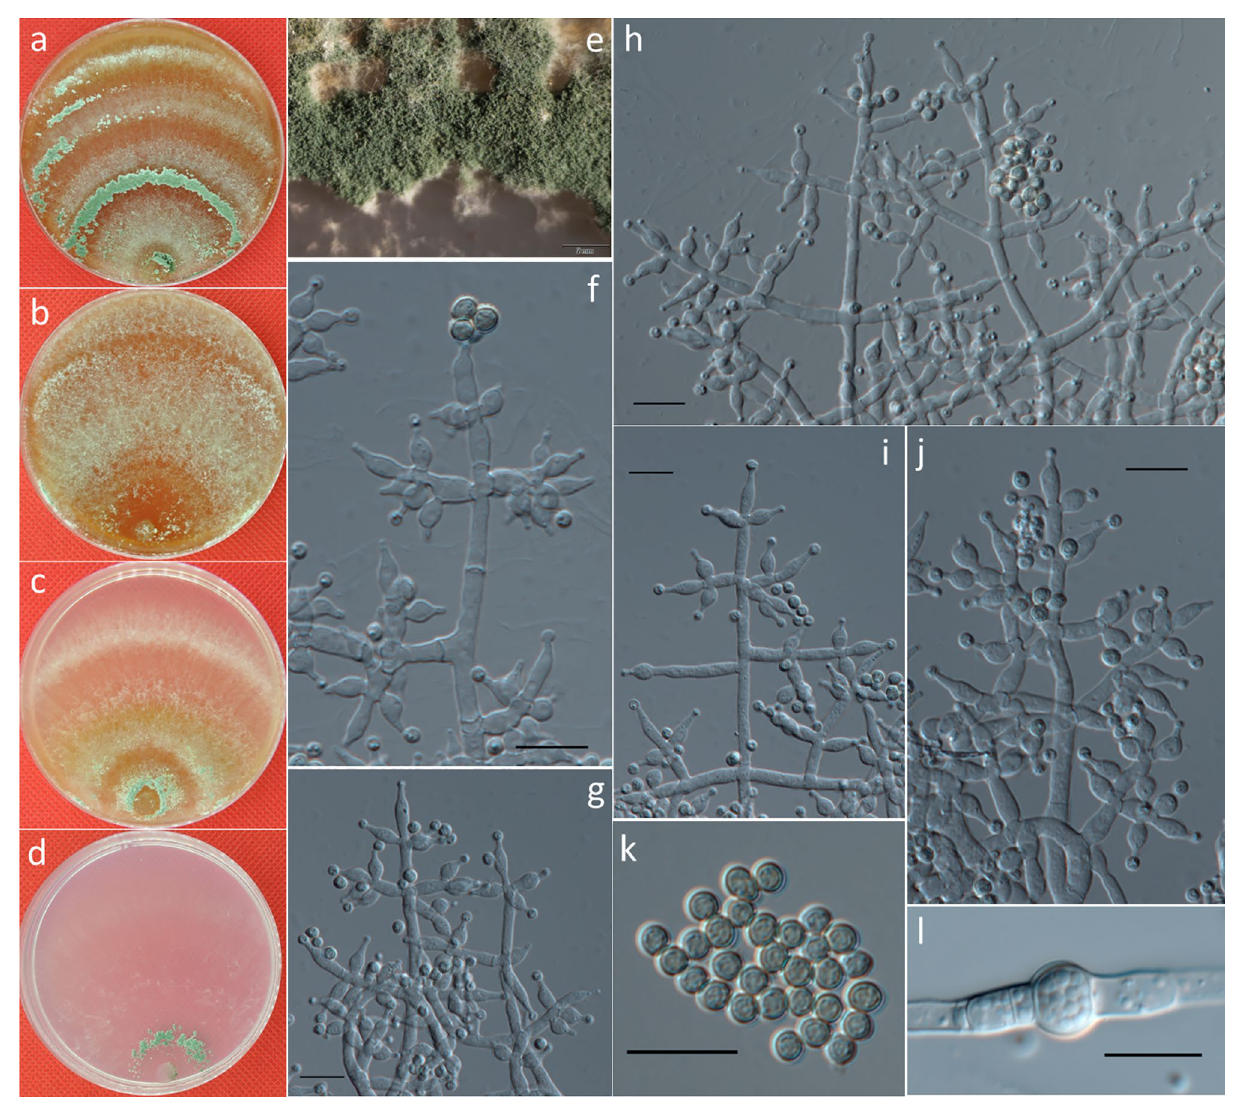
Figure 9. Cultures and asexual morph of Trichoderma pyramidale . ( a–d ) Cultures at 25 °C [( a ) on CMD, 7 days; ( b ) on MEA, 4 days; ( c ) on PDA, 4 days; and ( d ) on SNA, 4 days]. ( e ) Conidiation tuft (PDA, 7 days). ( f – j ) Conidiophores and phialides (CMD, 5–7 days). ( k ) Conidia (CMD, 6 days). ( l ) Chlamydospores (PDA, 7 days). Scale bars: ( e ) = 2 mm; ( f–l ) = 10 Description : Cultures and anamorph: optimal growth at 25 °C on all media. On CMD, growth of 10–11 mm/ day at 20 °C and 15–17 mm/day at 25 °C; and mycelium covers the plate after 6–7 days at 20 °C. Colony is dense with a wavy margin, and the surface becomes distinctly zonate (Fig. 10a). Aerial hyphae are numerous, long, elongate, and villiform in the plate (Fig. 10i). No diffusing pigment or odor. Autolytic activity is variable, and coilings are scarce or inconspicuous. Conidiation noted after 3–4 days at 20 °C. Conidiation is effuse and in intense tufts that are hemispherical or irregular, and they show wide wheel grain banding that is gray green to deep green. Conidiophores radiate from the reticulum and are broad, straight, sinuous or helically twisted, show distally slightly pointed elongations, taper from the main axes to top branches, and present primary branches arranged in pairs or in whorls of 2–3, with secondary branches to solitary. Phialides are 4.5–14 × 2.5–4 μm ( x = 7 ± 1.5 × 3.5 ± 0.3, n = 50) and 2–3.5 μm ( x = 3 ± 0.4) wide at the base, ampulliform, and in whorls of 3–6 (Fig. 10f–h,j,k). Conidia are 3.5–5.5 × 2.5–4 μm ( x = 4.5 ± 0.5 × 3 ± 0.2, n = 50), short cylindrical, and a gray color when single and pea green to yellow green in a group (Fig. 10l,n). On PDA, growth is 12–15 mm/day at 20 °C, 12–16 mm/day at 25 °C; and mycelium covers the plate after 4–5 days at 25 °C. Colony is denser with a wavy margin than that on CMD, and the surface is distinctly zonate (Fig. 10c). Aerial hyphae are numerous, long, and villiform to pulvinate in the plate. No diffusing pigment and odor (Fig. 10e). Autolytic activity is variable, coilings are scarce or inconspicuous. Chlamydospores examined after 7 days are 6.5–9.5 × 6–9 μm ( x = 7 ± 1.0 × 7 ± 0.9, n = 30), terminal and intercalary, globose or ellipsoidal, and smooth (Fig. 10m).